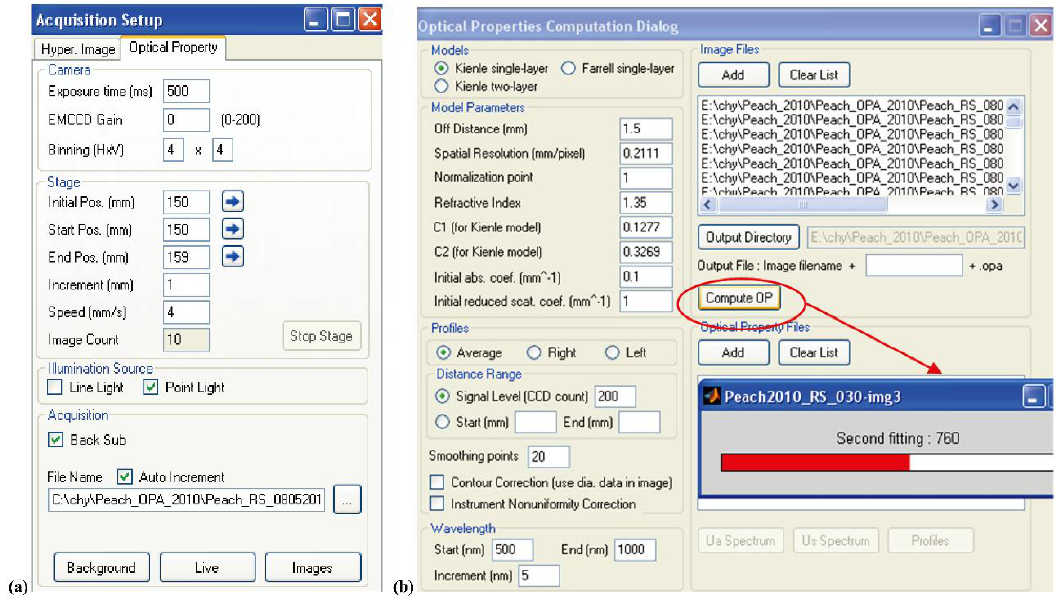
Figure 21. ( a ) Schematic and ( b ) photo of the hyperspectral imaging-based optical property analyzer (OPA).